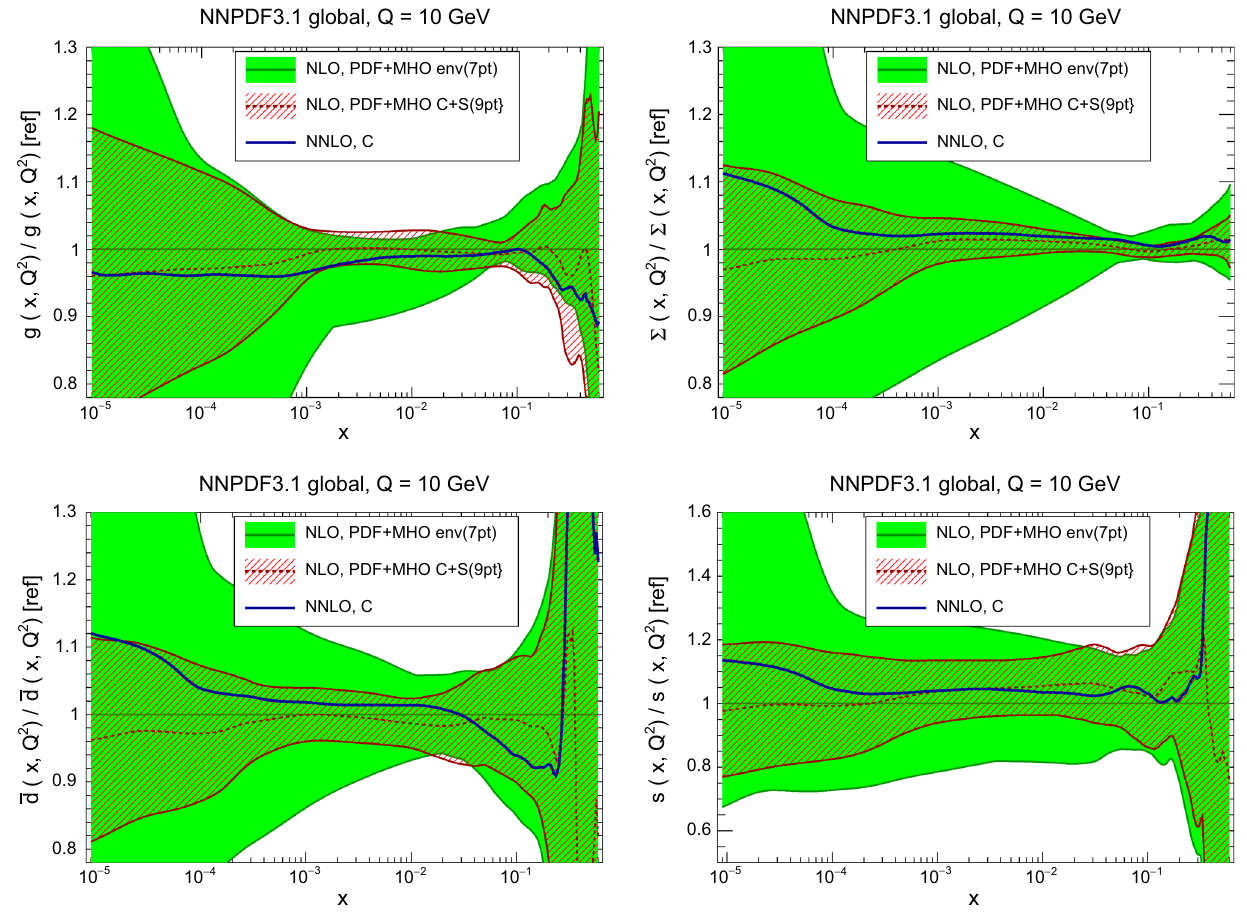
Fig. 28 Same as Fig. 27 comparing the total uncertainty obtained from the 7-point estimate of the MHOU using Eq. (B.3) to the total uncer- tainty obtained from the theory covariance matrix [same as Fig. 16)] computed using the 9-point prescription. The central NNLO value